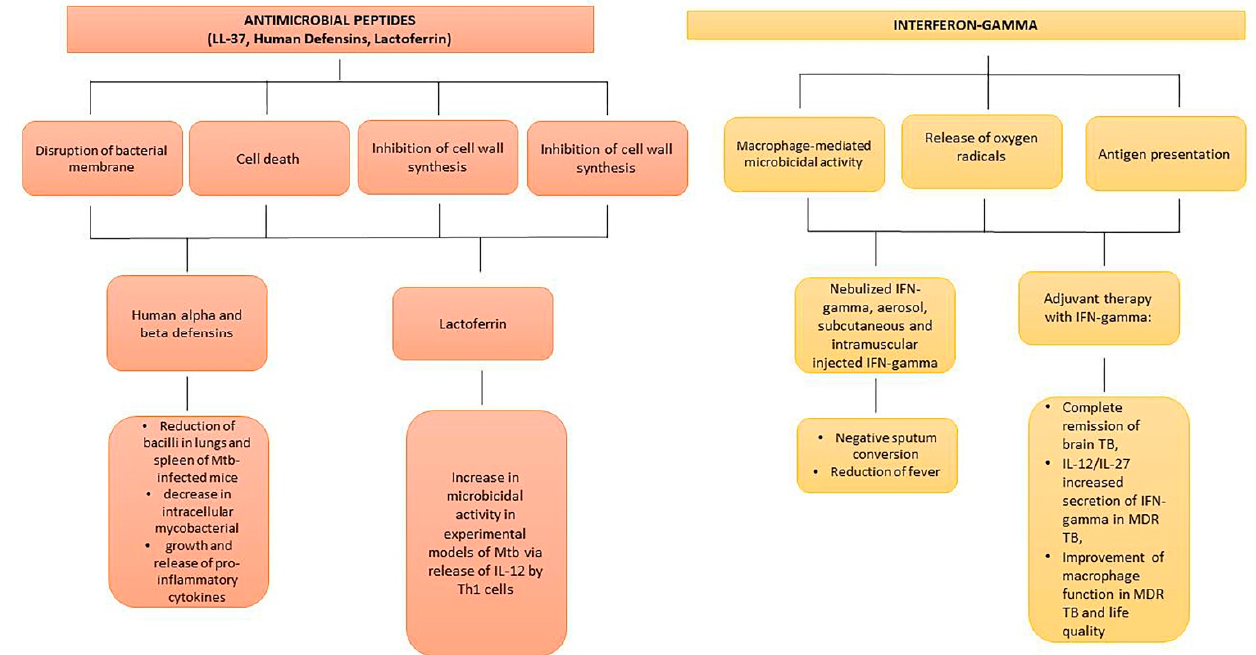
Figure 4. Biotherapeutics for treatment of experimental and human TB. AMPs target Mtb in different ways, inhibiting intracellular mycobacterial growth and reducing pro-inflammatory cytokines and IL-12 release by Th1 cells. Nebulized, aerosol, subcutaneous, and intramuscular IFN-gamma administration leads to sputum conversion, reduction of fever, and improvement of life quality in severe human TB.